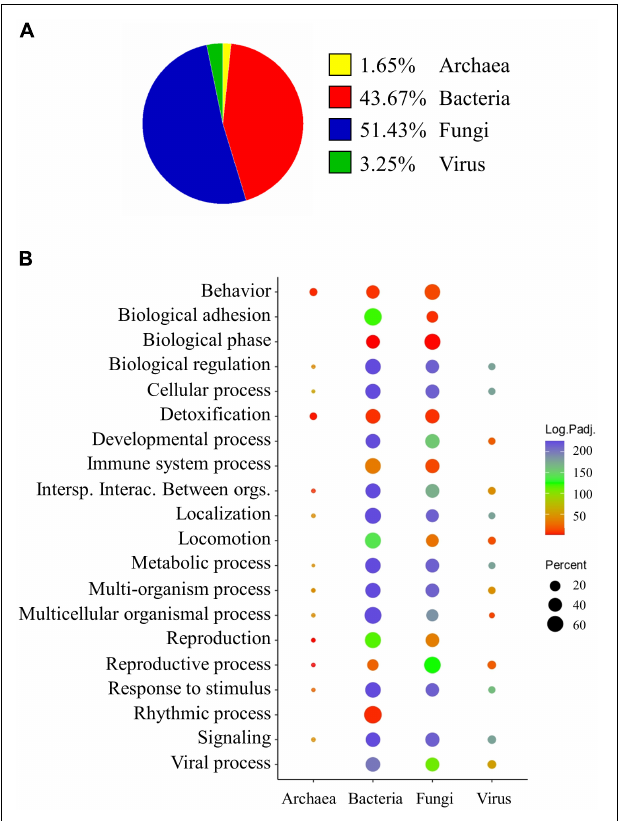
FIGURE 2 | (A) Pie chart showing the relative expression of assembled unigenes associated to gut microbial communities according to their assigned taxonomy. (B) Dot plot depicting the results of an over-representation test performed over the Biological Process Gene Ontology terms (GO-BP) of each one of the assigned taxonomies. The size of the dots represents the percentage of genes in this category, which were retrieved with our assembly strategy in each group. The colour scale represents the –log 10 Padj value obtained in the over-representation test of each pathway within each